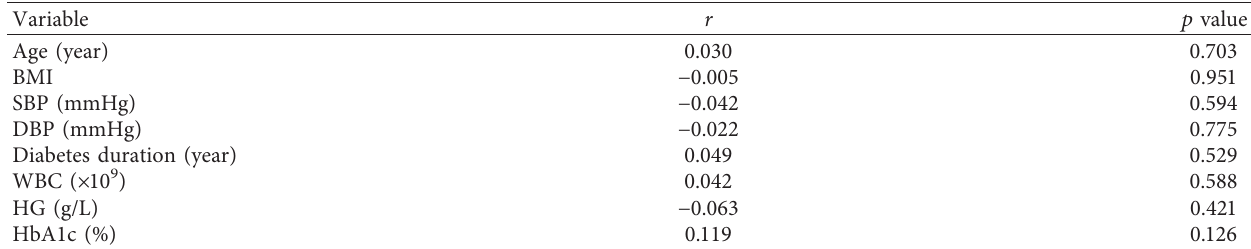
Figure 4: The proportion of DM and DR patients in subgroups defined by the quartile of RDW. Q 1: 10.9% < RDW ≤ 12.2%, Q 2: 12.2% < RDW ≤ 12.75%, Q 3: 12.75% < RDW ≤ 13.3%; and Q 4: 13.3 < RDW ≤ 19.5%. Table 3: Correlation analysis of RDW with other factors in DR patients.